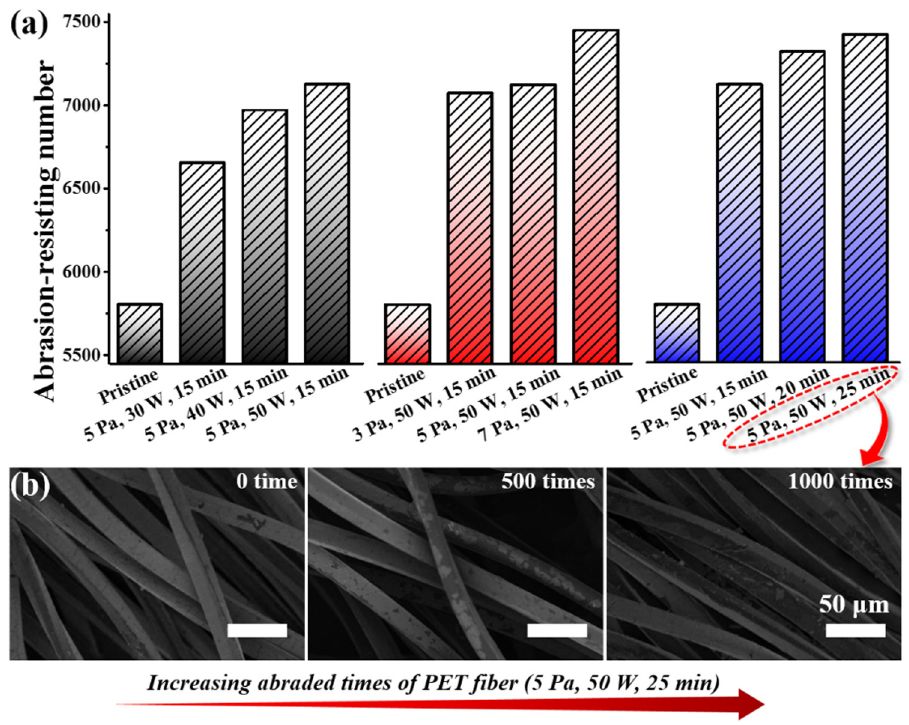
Figure 6: ( a ) Comparison of abrasion resistance of PET fi bers under di ff erent sputtering conditions; ( b ) the consecutive SEM photographs of SS - sputtered PET fi ber following di ff erent abrasion